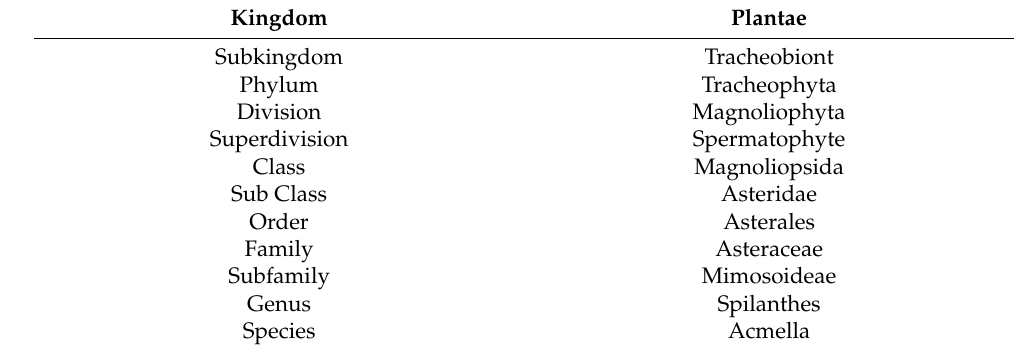
Table 1. Taxonomic of S. acmella.